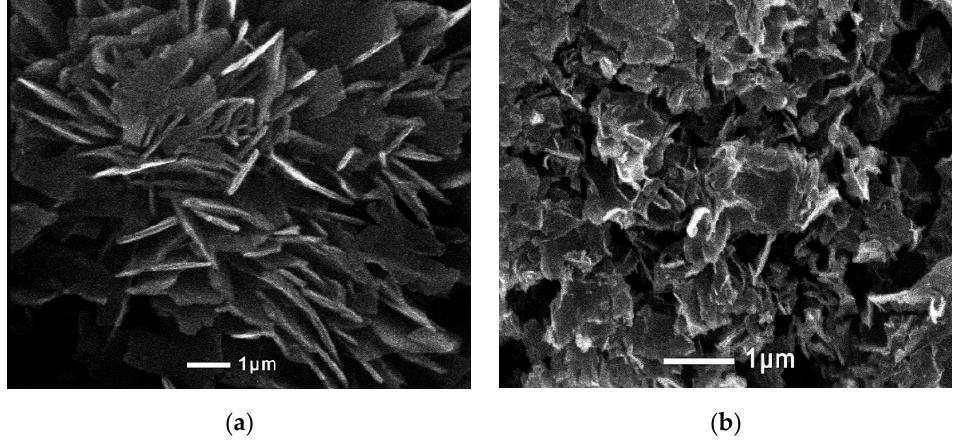
Figure 3. SEM photographs of G0 ( a ) and G1 ( b ) powders.